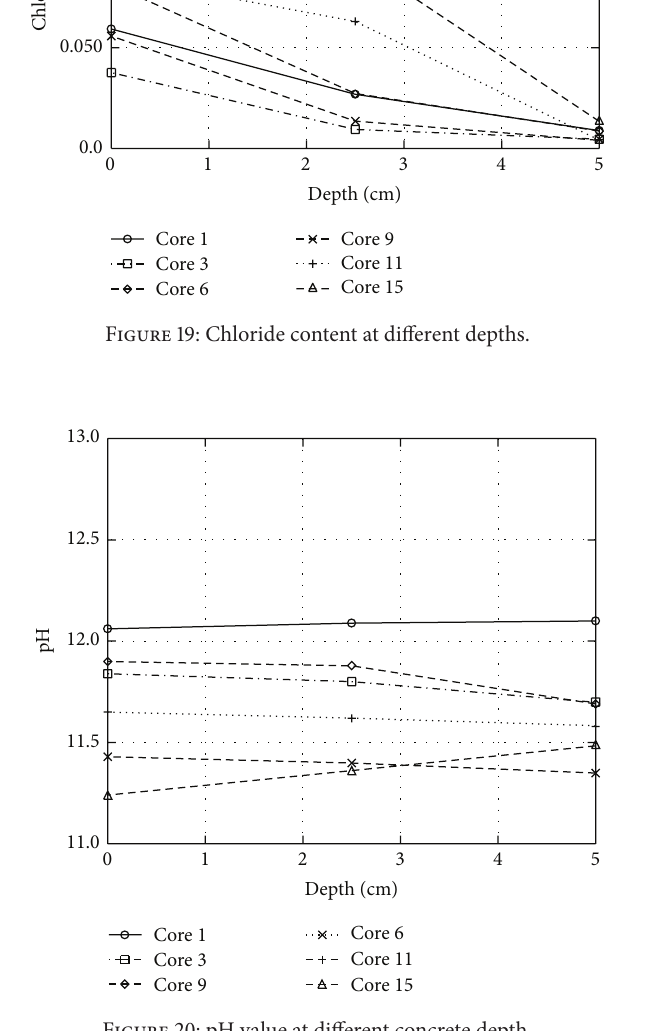
Figure 20: pH value at different concrete depth.